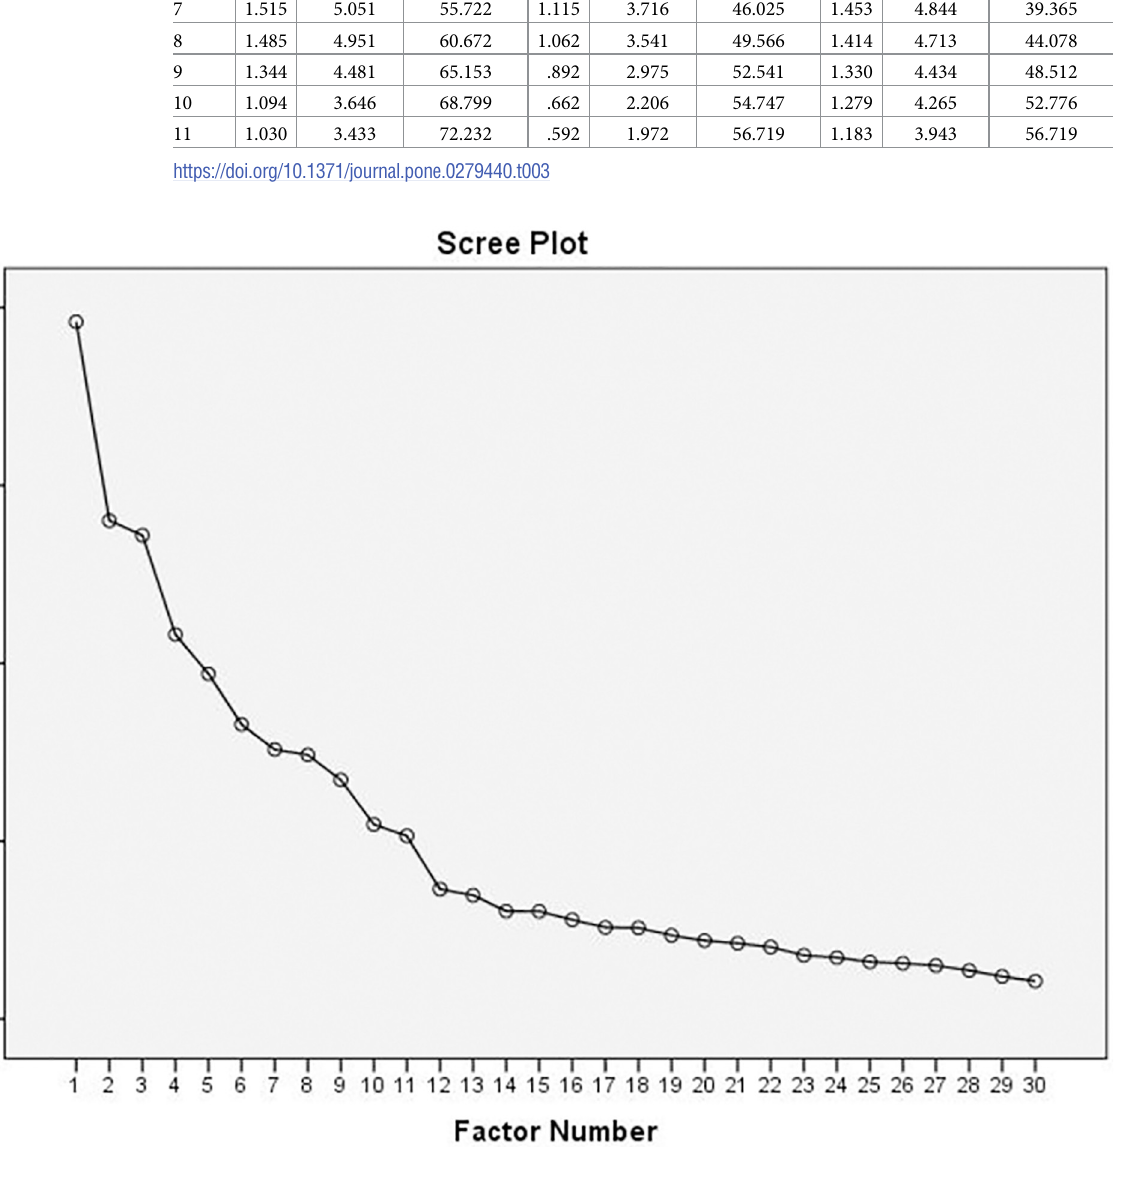
PLOS ONE | https://doi.org/10.1371/journal.pone.0279440 December21,